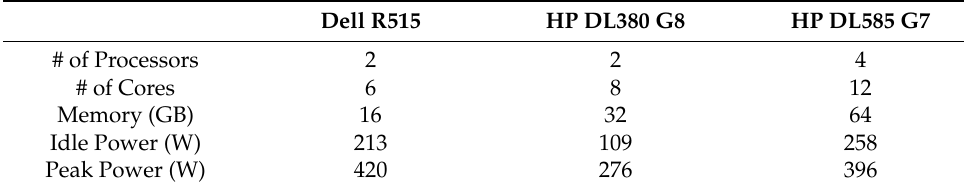
Table 2. Properties of PMs.